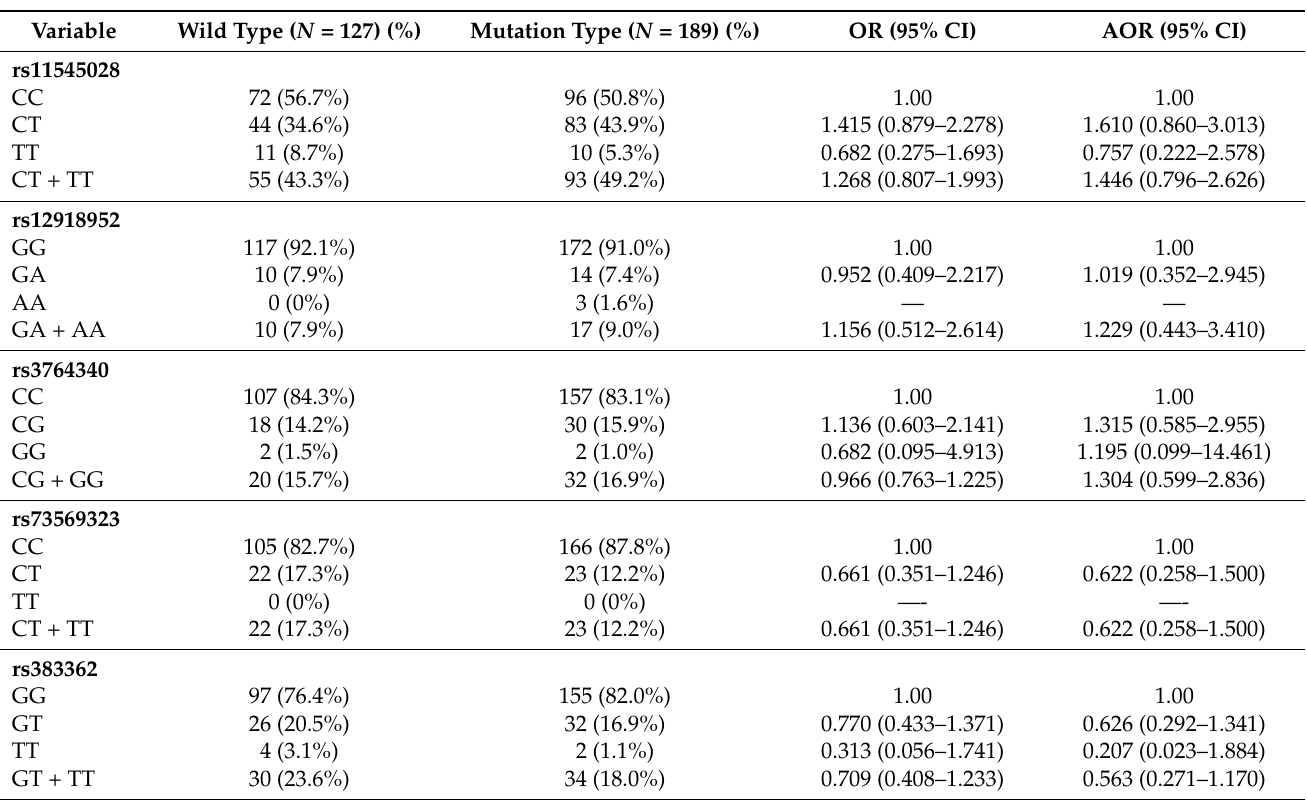
Table 2. Distribution frequency of WWOX genotypes of 127 EGFR wild type and 189 EGFR mutation type in lung adenocarcinoma